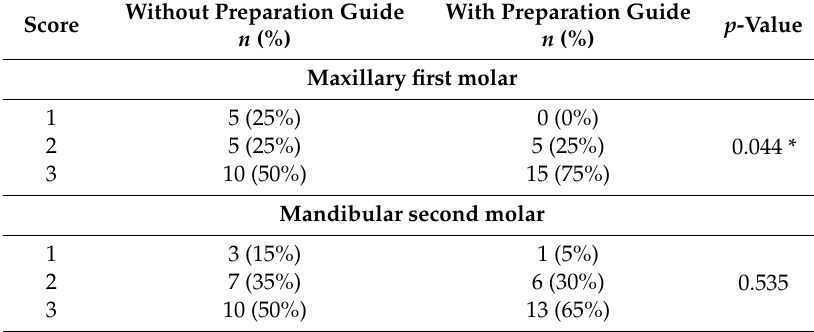
Table 2. Harmony